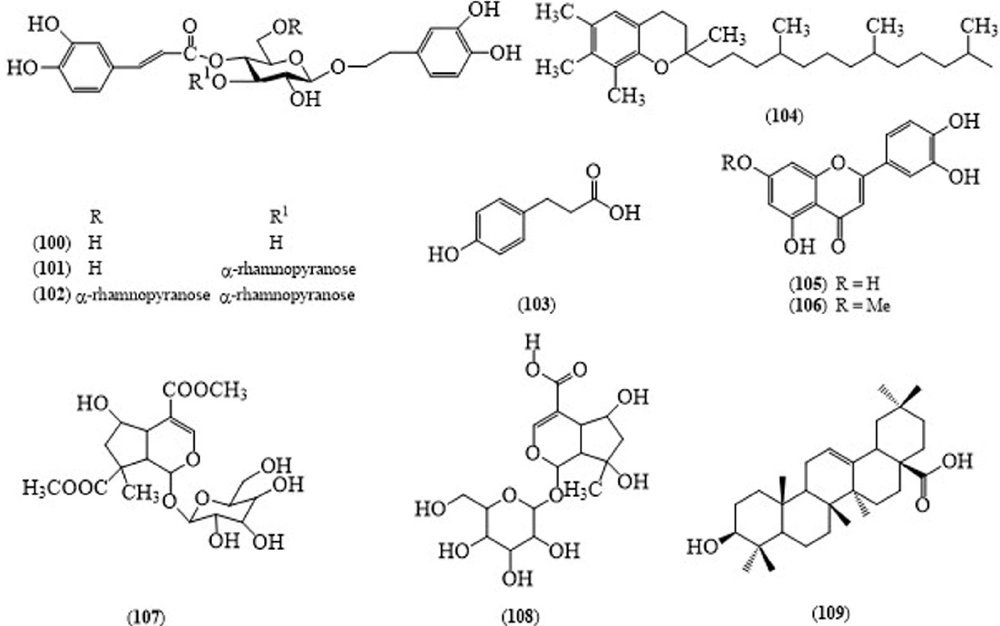
Figure 9. Structures of selected compounds isolated from Barleria cristata.